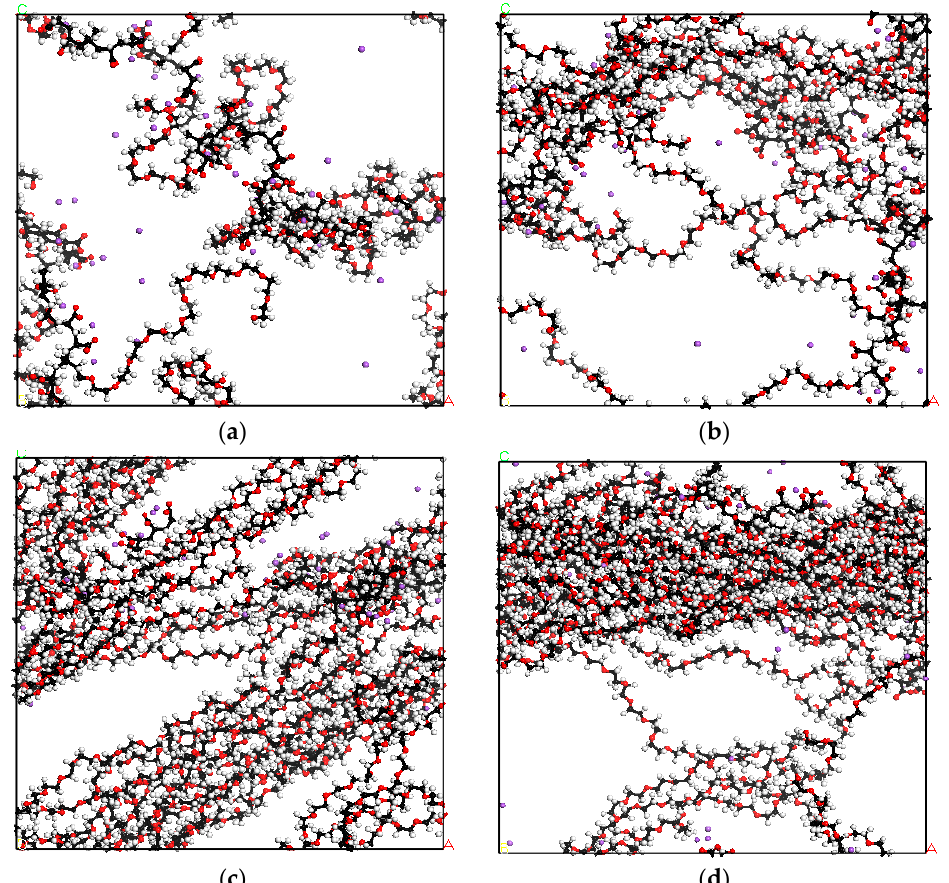
Figure 3. The snapshots of ( a ) PCE1, ( b ) PCE2, ( c ) PCE3, and ( d ) PCE4 in aqueous systems. The black, red, and white balls represent carbon, oxygen, and hydrogen atoms, respectively.